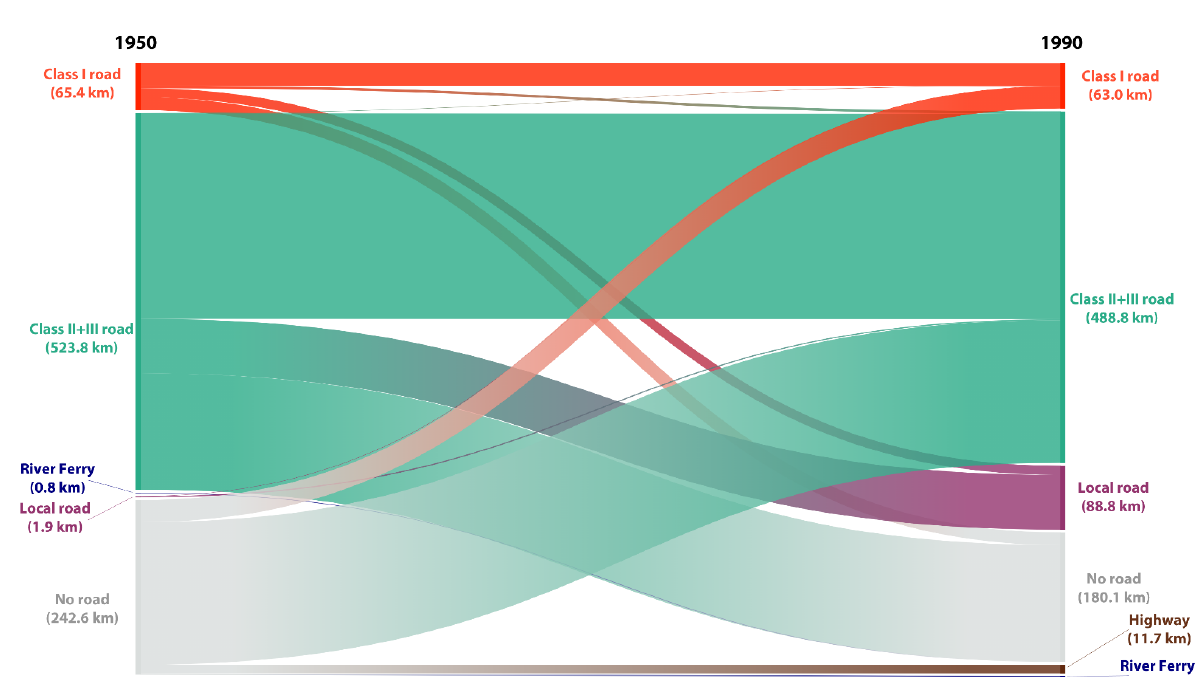
Figure 4. Visualizing the road network changes between 1950 and 1990 [km]. In the third period, similarly to the first one, a small sample of lakes is assessed, which may bias the results considerably. The only Class I road that passed through the study